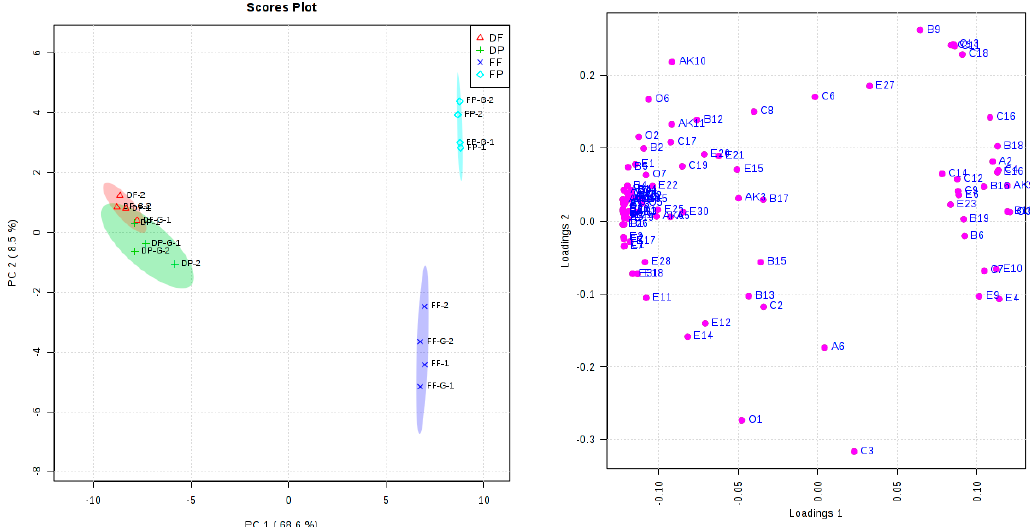
Figure 1. Principal component analysis (PCA) of goji berry fermented wine made of fresh and dried goji berry under pressing and glycosidase treatment. Left—Scores plot; Right—Loading plot; Volatiles with abbreviation of A1-O8 in loading plot are named in Table 3. “1”, “2” in scores plot represent two replicates for each goji berry fruit wine fermentation treatment.